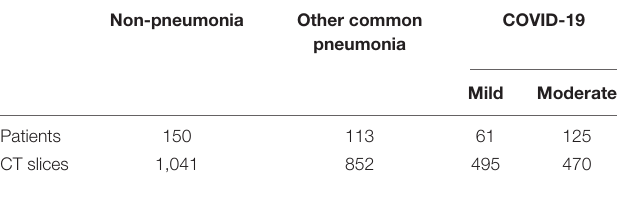
TABLE 1 | Summary of the patients’